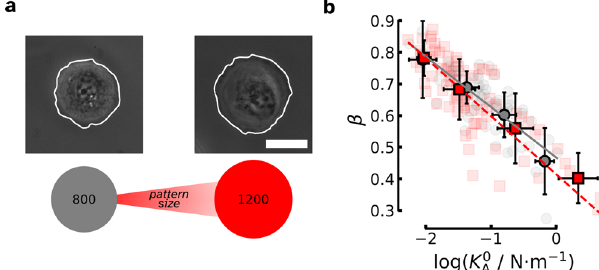
Fig. 7 Giant liposomes versus epithelial cells. Comparison of force- Fig. 6 Impact of stress generated by different extracellular matrix (ECM) relaxation experiments performed on individual epithelial cells ( a ) and actin- sizes on cellular mechanics. a Phase-contrast micrographs of single MDCK fi lled giant liposomes ( b ). The insets show representative confocal images of II cells (outlined in white) adhered to ECM spots with different sizes, the cells and giant liposomes, with the actin cytoskeleton labeled in green 800 μ m 2 on the left and 1200 μ m 2 on the right. Scale bar is 20 μ m. (Alexa Fluor 488 actin) and the plasma membrane in red (Texas Red ÞÞ scaling. The gray circles denote b Impact of cell size on the β ð log ð K 0 A DHPE), respectively. Fits with the corresponding shape function to the force- MDCK II cells adhered to the 800 μ m 2 large extracellular matrix (ECM) relaxation data are shown as red lines corresponding to σ 0 = 0.5 mNm − 1 , spot size with a gray solid trend line ( n = 53 curves, 12 cells). The red K 0 ¼ 0 : 05 N m − 1 and β = 0.6 for the MDCK II cell ( δ max ¼ 2 : 5 μ m, A squares correspond to cells cultured on a 1200 μ m 2 large ECM spot with a v = 0.5 μ m/s, R = 12 μ m) and σ = 2.7 mNm − 1 , K 0 ¼ 0 : 11 Nm − 1 and 0 cell 0 A dashed red line indicating the linear trend ( n = 77 curves, 15 cells.) For the β maximum indentation depths, δ max see Supplementary Fig. 8 30 .